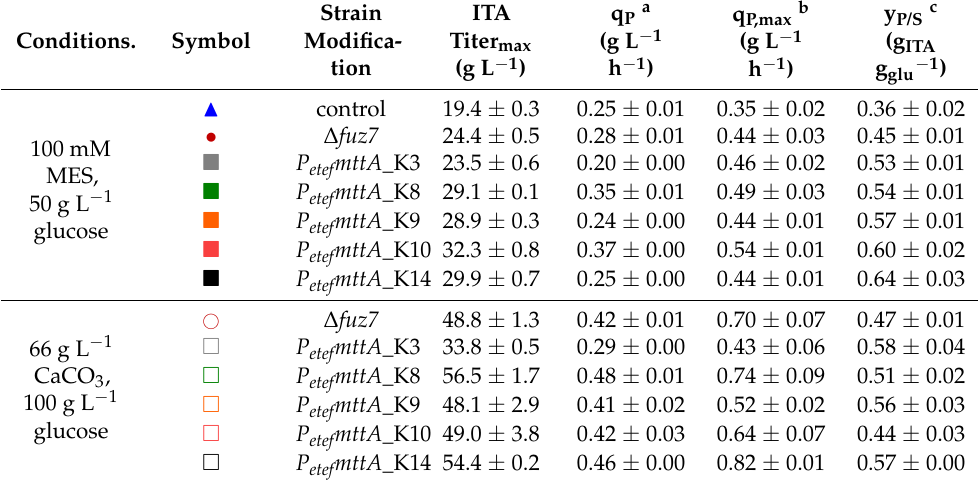
Table 3. ITA production parameters of engineered strains of the U. maydis MB215 ITA chassis ( ∆ cyp3 ∆ MEL ∆ UA ∆ dgat ∆ P ± values indicate the standard error of the mean ( n = 3). ria1 :: P etef ).